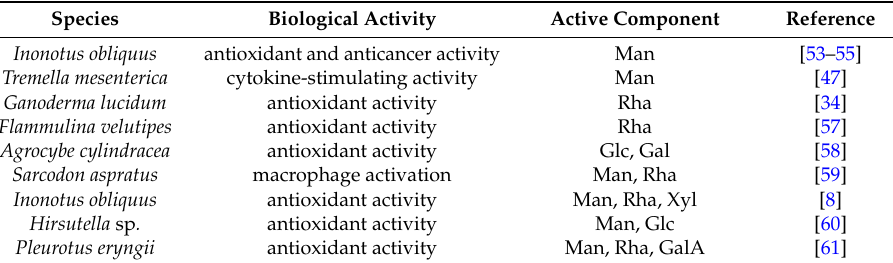
Table 3. Biological activities of active components in mushroom